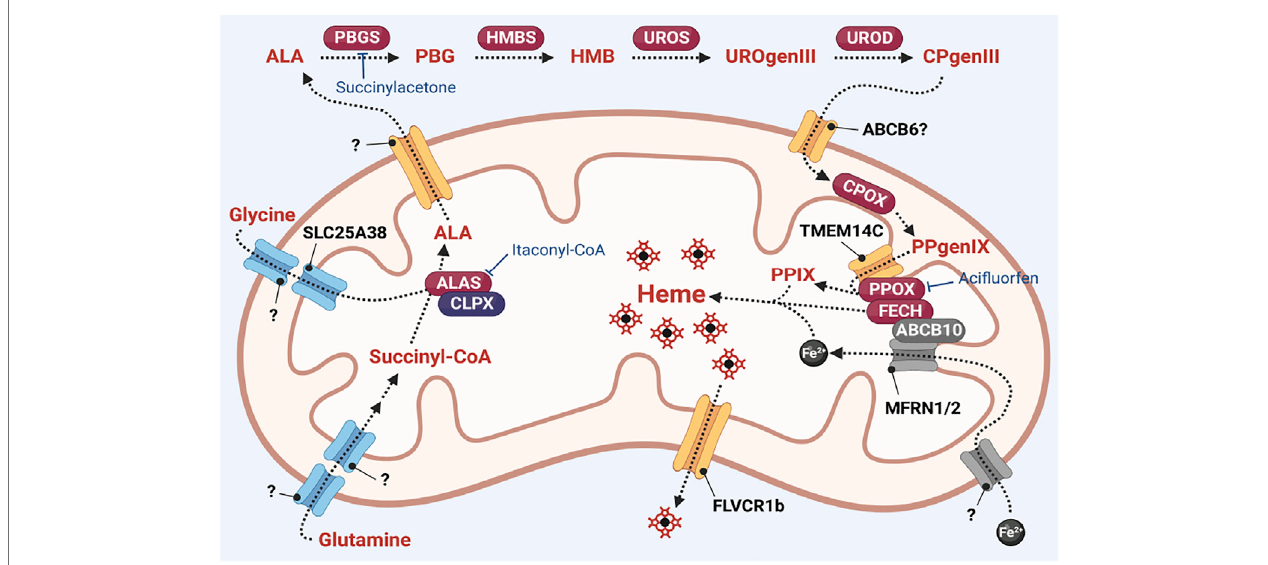
FIGURE 2 | Overview of heme synthesis. Heme synthesis requires the activity of its pathway enzymes (indicated in red ovals). The activities of these enzymes are regulated by interaction with mitochondrial homeostasis proteins such as CLPX and ABCB10. Heme synthesis is also regulated by transport proteins such as TMEM14C,andtransportofiron via theMFRNproteins.Manytransportersofhemeintermediateshaveyettobeidenti fi ed.Pharmacologicalinhibitorsofhemesynthesis enzymes such as itaconyl-CoA (inhibitor of ALAS (63, 153)), succinylacetone (inhibitor of PBGS/ALAD (Ebert et al., 1979)) and aci fl uorfen (inhibitor of PPOX (Corrigall et al., 1994; Corradi et al., 2006)) are powerful tools to probe the regulatory mechanisms of the heme synthesis pathway.